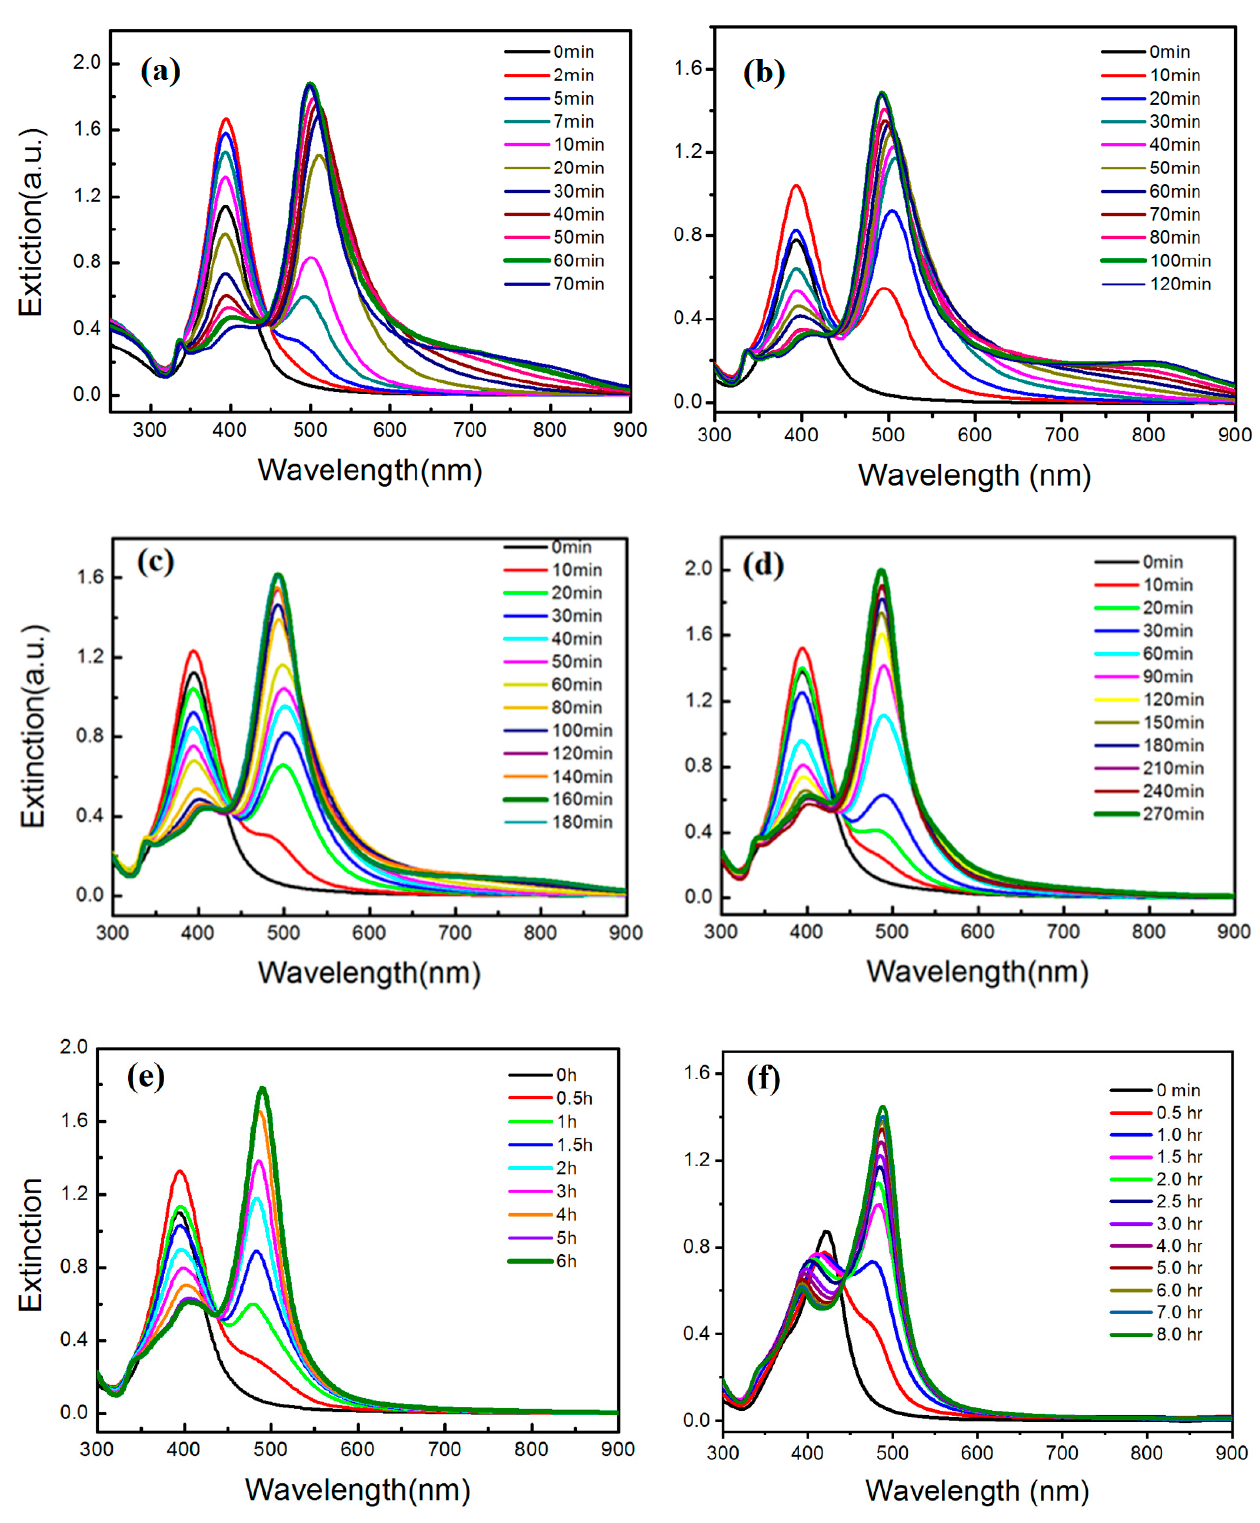
Figure 1. Time-dependent UV–vis spectra of silver colloids synthesized at ( a ) 60 °C; ( b ) 40 °C; ( c ) 30 °C; ( d ) 20 °C; ( e ) 10 °C; and ( f ) 0 °C.